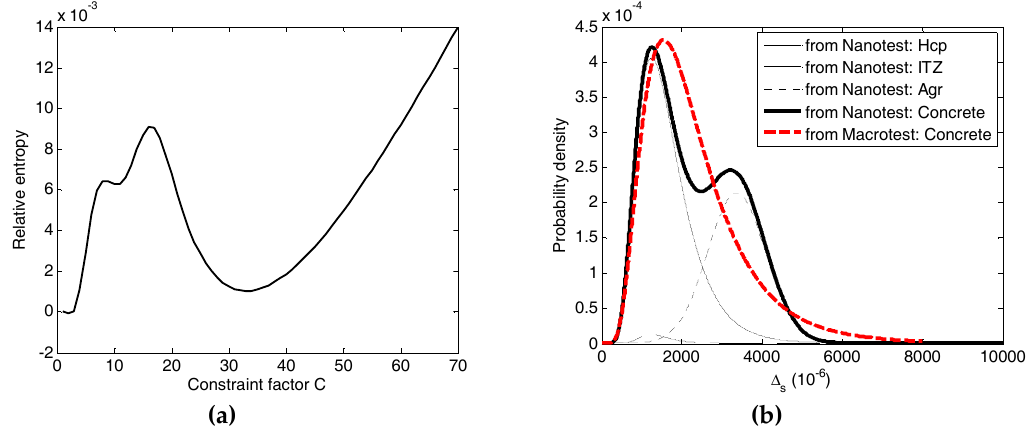
Figure 10. SFS from the nano- and macro-testing: ( a ) the relative entropy vs. the constraint factor. ( b ) PDFs from two different scales corresponding to the smallest relative entropy.